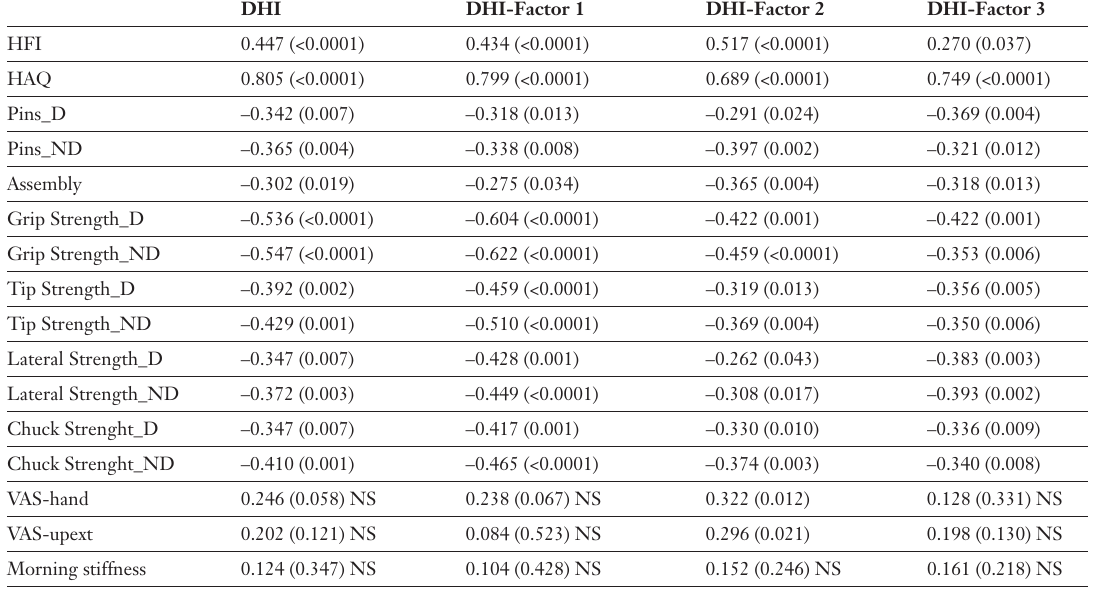
Spearman’s Corre- lation Coefficient of DHI with functional and clinical para-